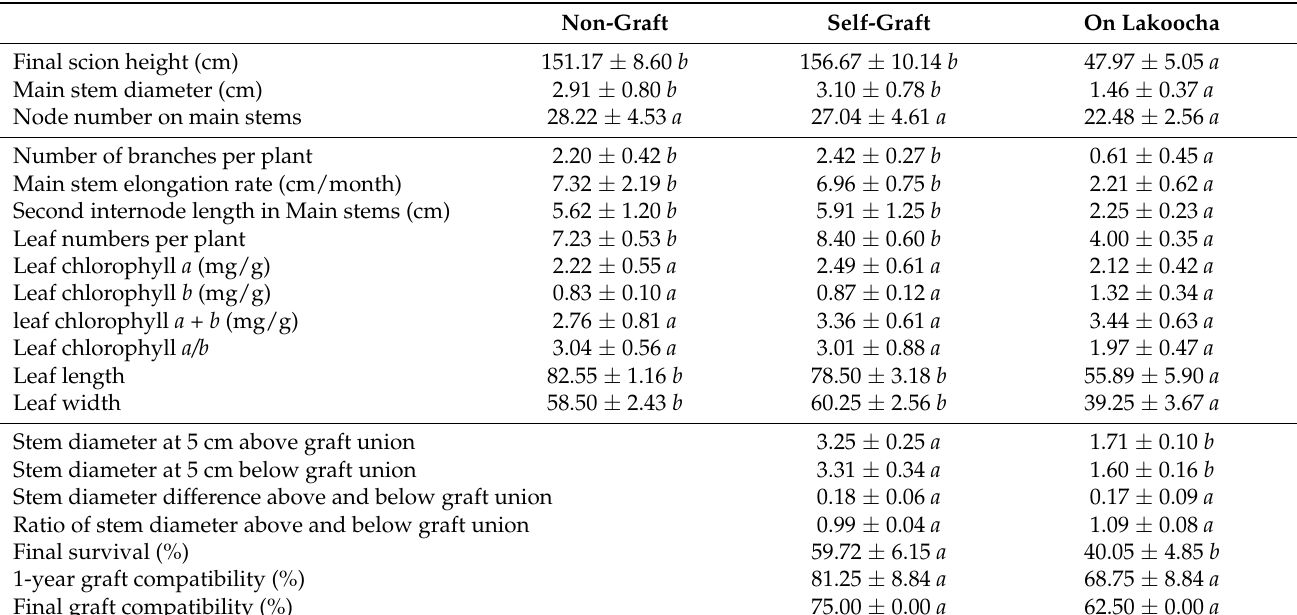
Table 1. Morphological assessment of breadfruit plants growing on different rootstocks